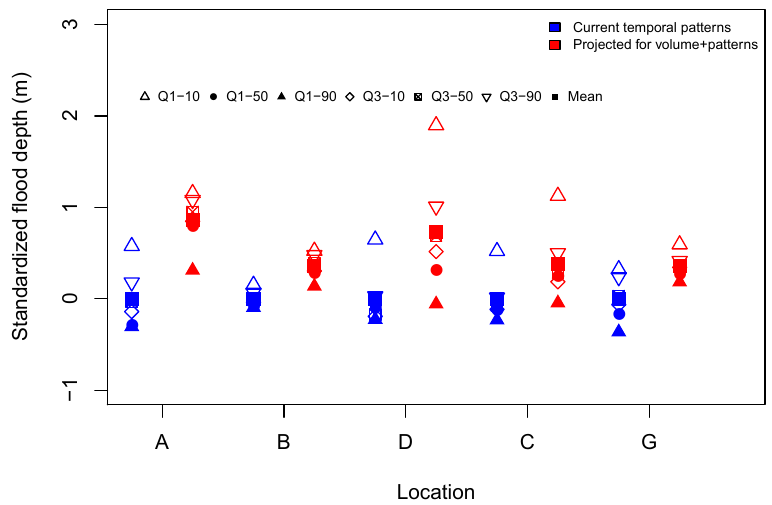
Figure 9. Impact of rise in temperature on the peak flood depth variation at reference locations within the watershed, when scaling is applied to both rainfall volume and temporal pattern. The peak flood depths at each reference point are based on 210mm of total rain distributed over the six temporal patterns used. Flood depths were standardized by subtracting the mean from the base simulations presented in Fig. 6 for each location. The mean flood depth is shown as solid